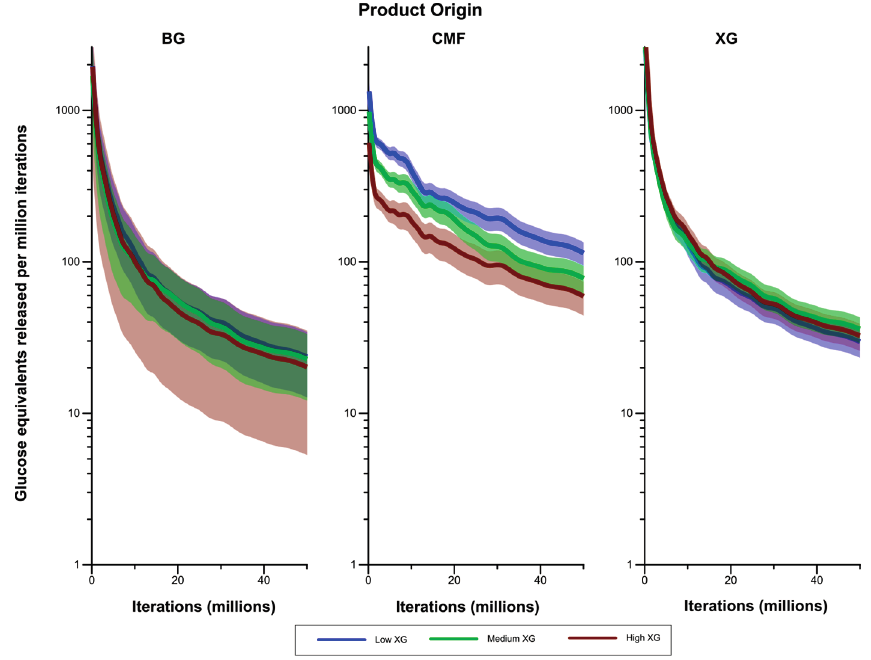
Figure 11. Rates of liberation of glucose equivalents from the degradation of (1,3;1,4)- β -glucans (BG) and CMF and XG in the Low, Medium and High XG walls. The shaded region represents a 95% Least Significant Interval so that any two of the three curves are significantly different at the 5% level where their bands do not overlap. The solid line in the middle indicates the mean